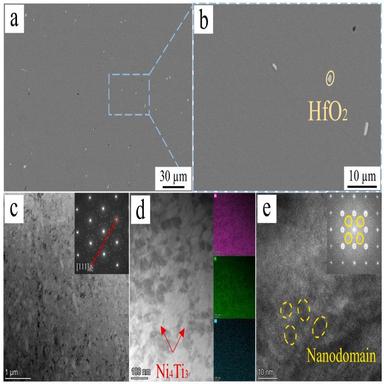
Microscopic morphology of Ni55Ti37Hf8 alloy after pre-aging treatment, (a)-(b) SEM morphology, (c) Low-magnification TEM morphology, (d) HADDF morphology with corresponding elemental mapping of Ni (purple), Ti (green), and Hf (blue), (e) High-resolution morphology of matrix.